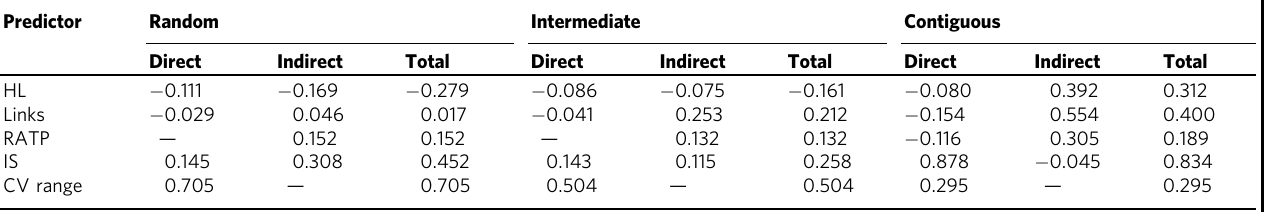
Table 2 Direct and indirect effects sizes of predictor variables on stability (CV population) Predictor Random